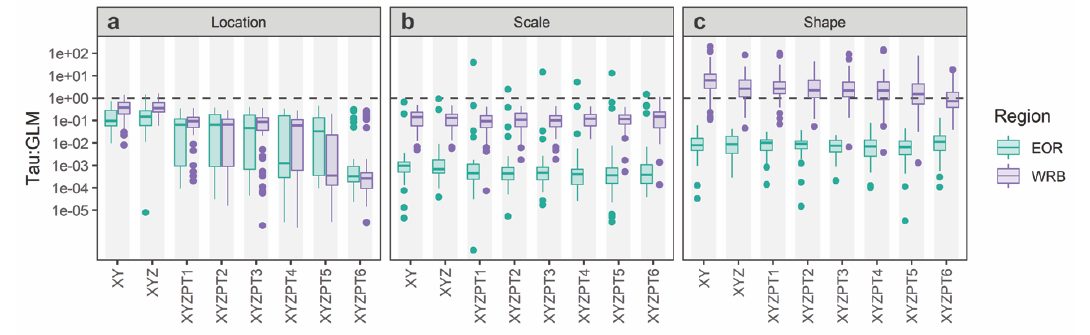
Figure 6. The contribution of the spatial random effects term relative to the general linear model (GLM) term for each GEV parameter and model. The dashed horizontal line is placed at one, representing a 1:1 ratio of the spatial random effects term to GLM. ( a ) is location, ( b ) is scale and ( c ) is shape.